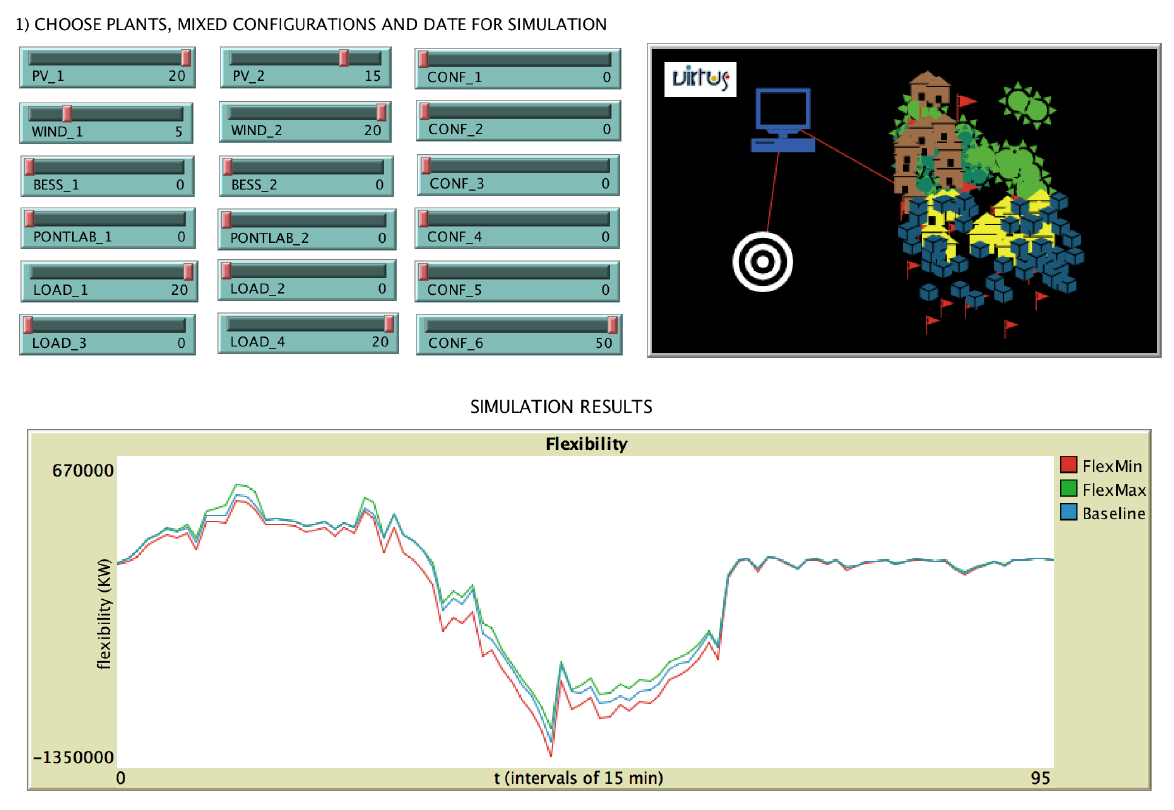
Figure 17. ( Up ) Case study 1 setting. ( Down ) Case study 1